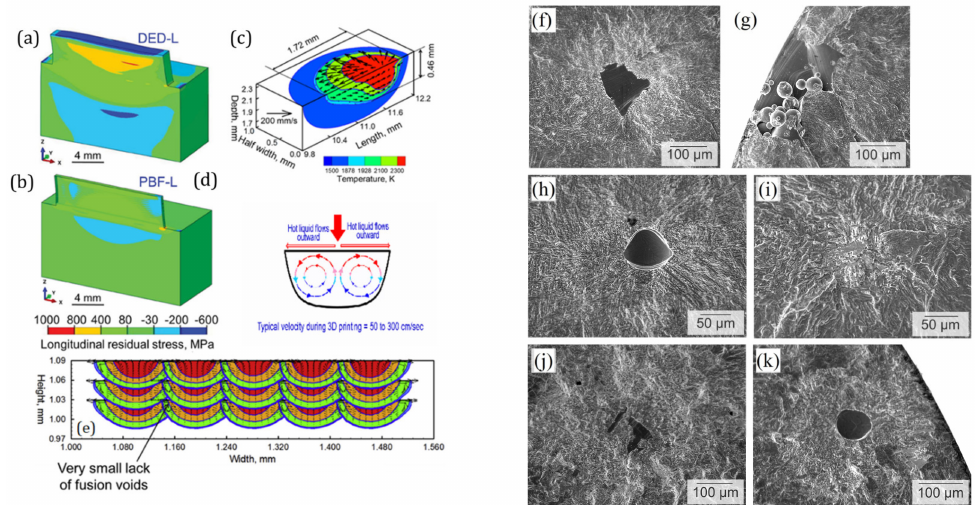
Figure 7. Longitudinal residual stress distribution in ( a ) DED and ( b ) SLM. ( c ) Temperature and velocity distributions during the deposition of the 2nd layer of Ti64. ( d ) Motion of the molten pool. ( e ) Transverse-sectional view of the molten pools for three layers and five hatch builds of Ti6Al4 V using 60W laser power 1000 mm/s [41,43]. ( f ) Lack of fusion defects in SLM with a stress amplitude of 353 MPa and 1.4 × 10 7 cycles to failure. ( g ) Lack of fusion in SLM caused by inadequate consolidation of the powder particles with unmolten particles visible at the defect’s inner surface with a stress amplitude of 342 MPa and 1.56 × 10 5 cycles to failure. ( h ) Approximately circular pore created by trapped gas during SLM with a stress amplitude of 342 MPa and 5.59 × 10 7 cycles to failure. ( i ) α -phase defect type observed in SLM with a stress amplitude of 560 MPa and 1.17 × 10 7 cycles to failure. ( j ) Lack of fusion defects observed in EBM with a stress amplitude of 250 MPa and 2.3 × 10 8 cycles to failure. ( k ) Approximate circular pore in EBM with a stress amplitude of 250 MPa and 1.6 × 10 8 cycles to failure